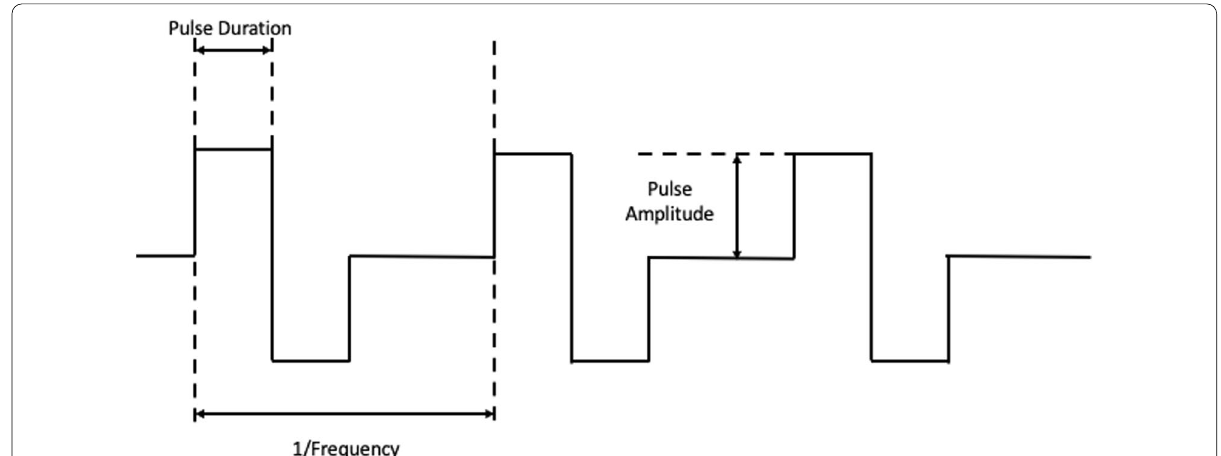
Fig. 1 Functional electrical stimulation parameters: pulse duration, pulse amplitude, and pulse